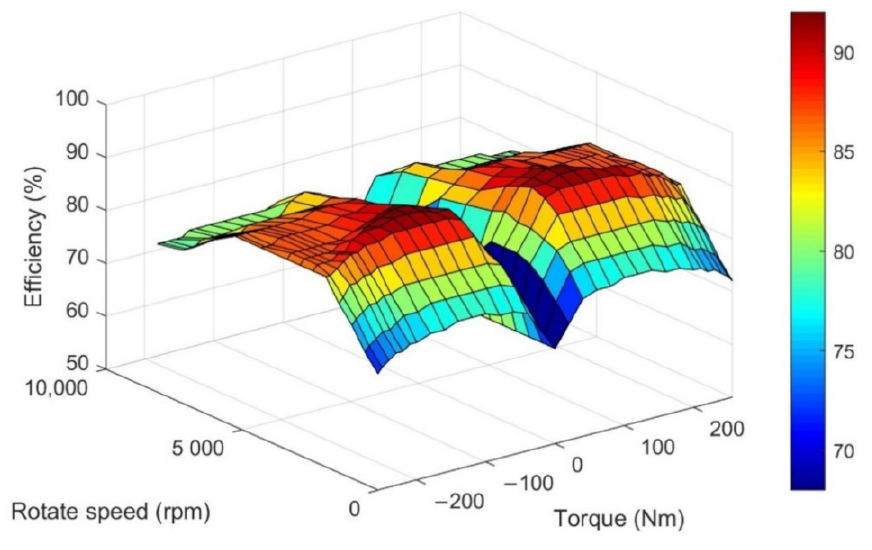
Figure 2. Motor-efficiency